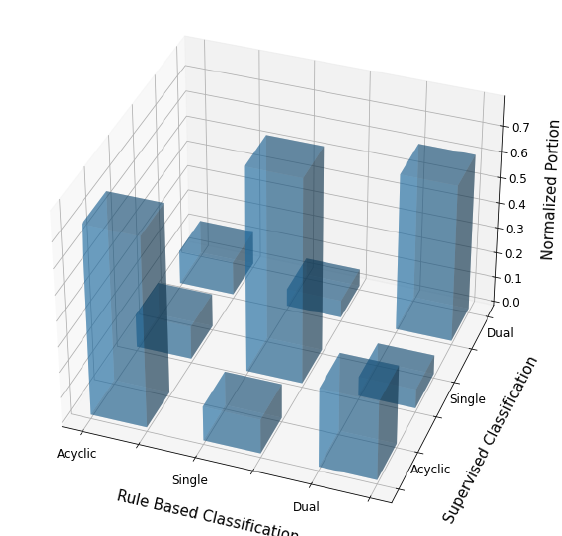
Figure 18. Comparing classification results from different approaches in a comparison matrix. The height for each bar in the Z axis is normalized by the sum of the pixels in each category from rule based classification.